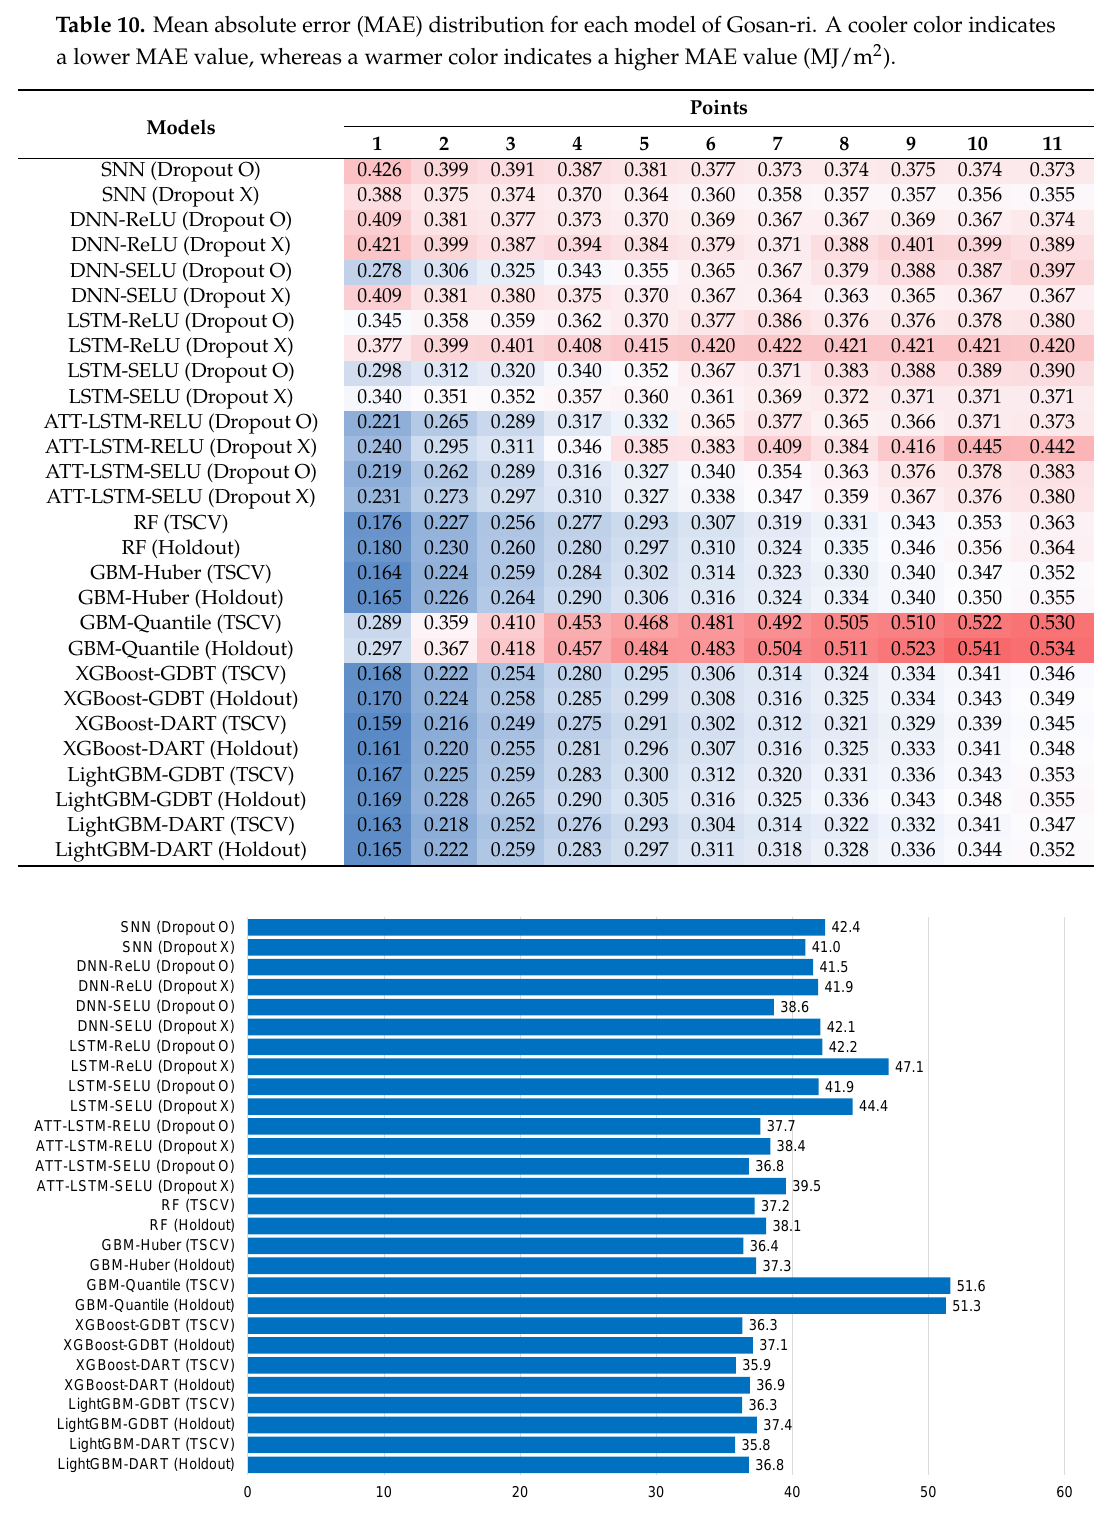
Figure 9. Average normalized root mean square error for each model of Ildo-1 ( % ).